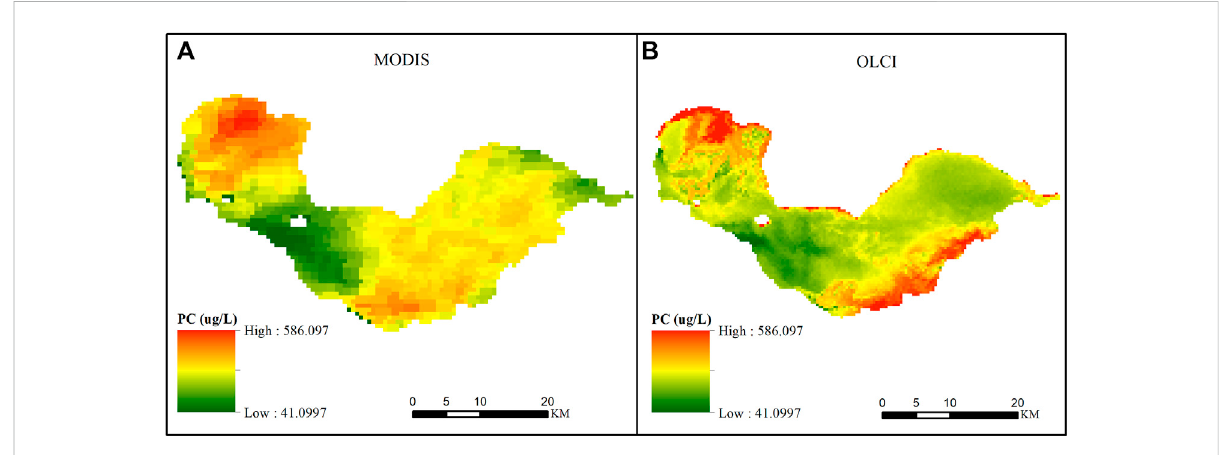
values (Figure 2B). The GBT regression model for OLCI